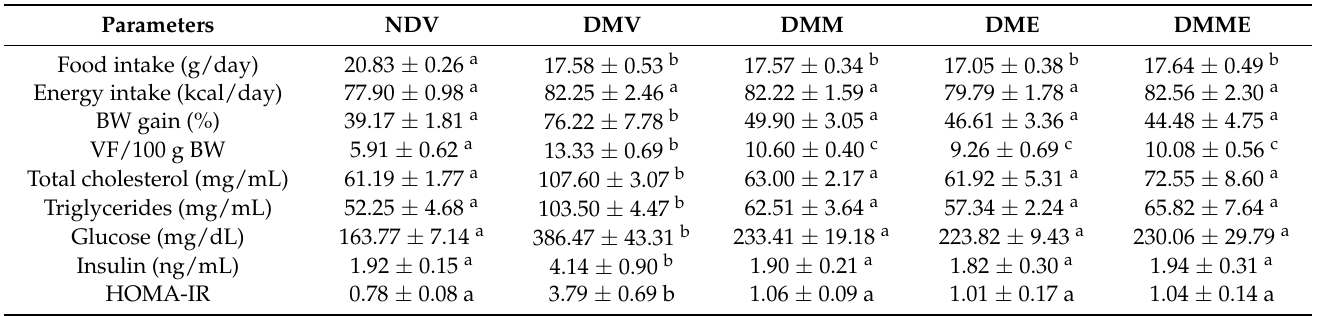
Table 1. Effects of purple rice husk extract (PRHE) and metformin on metabolic indexes.